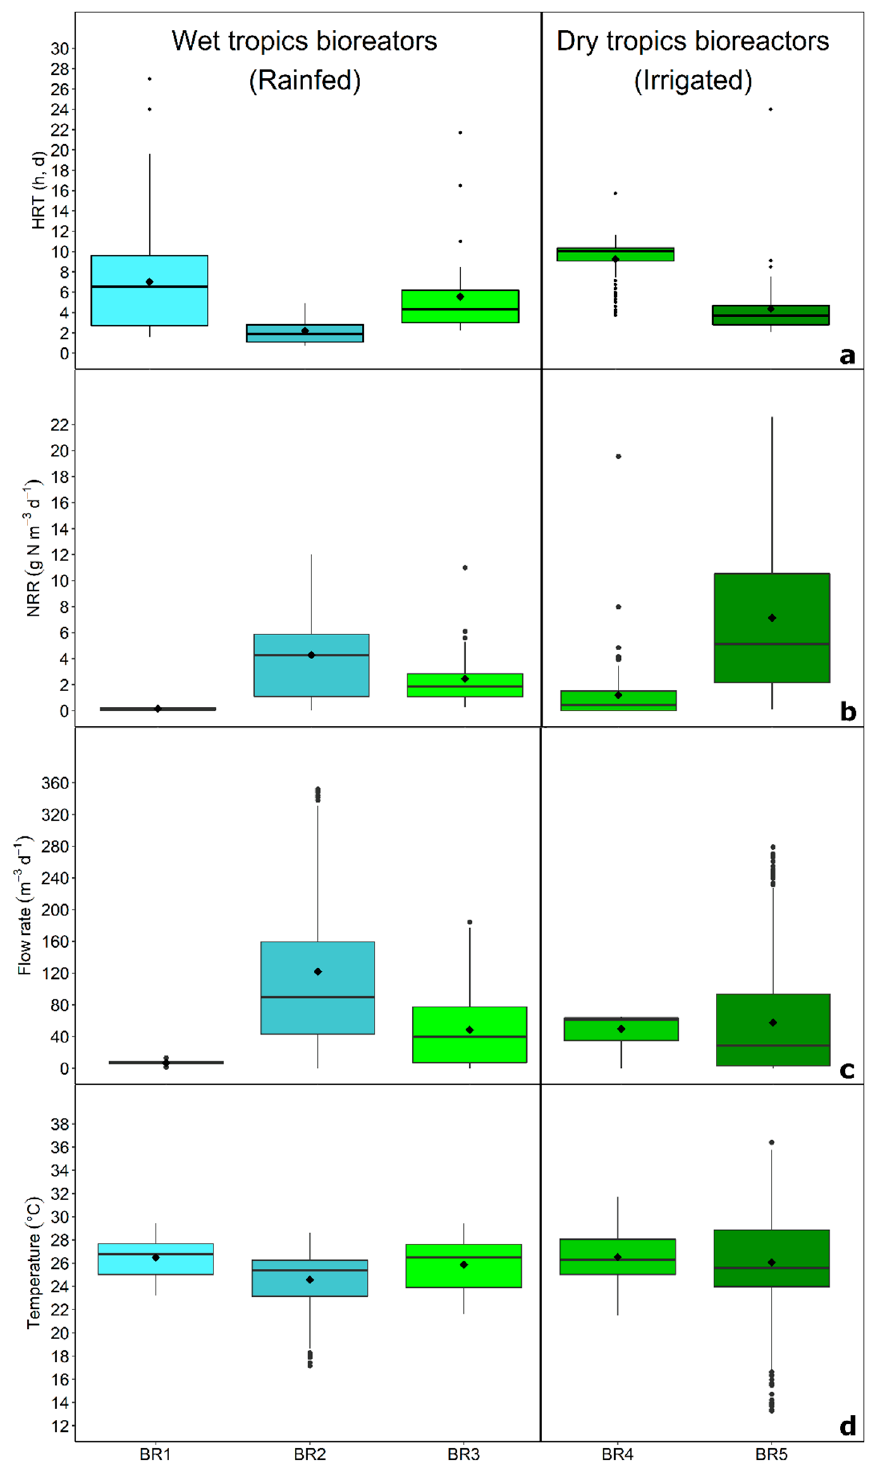
Figure 3. Boxplots of hydraulic residence time (HRT, a ), NO 3 − removal rate (NRR, b ), flow rate ( c ), and temperature ( d ) of the wall BR1, and the beds BR2 – BR5. Note that the HRT of the wall BR1 is expressed in days (d), whereas the HRT of the beds BR2 – BR5 is expressed in hours (h). The temperature was measured using pressure transducers installed in the wall transect (T2) of BR1, in the outlet structures of BR2 and BR3, and in the outlet piezometers of BR4 and BR5. The solid line is the median, the black diamond is the mean, and black circles are the outliers.